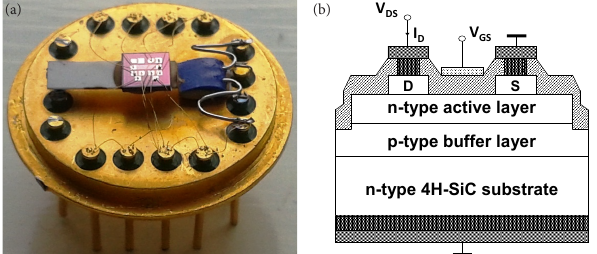
Figure 1. (a) Sensor chip mounted on a 16-pin TO8 header and glued on a ceramic heater together with a Pt100 temperature sensor. (b) Cross-sectional view of the SiC based field effect transistor used in this work.